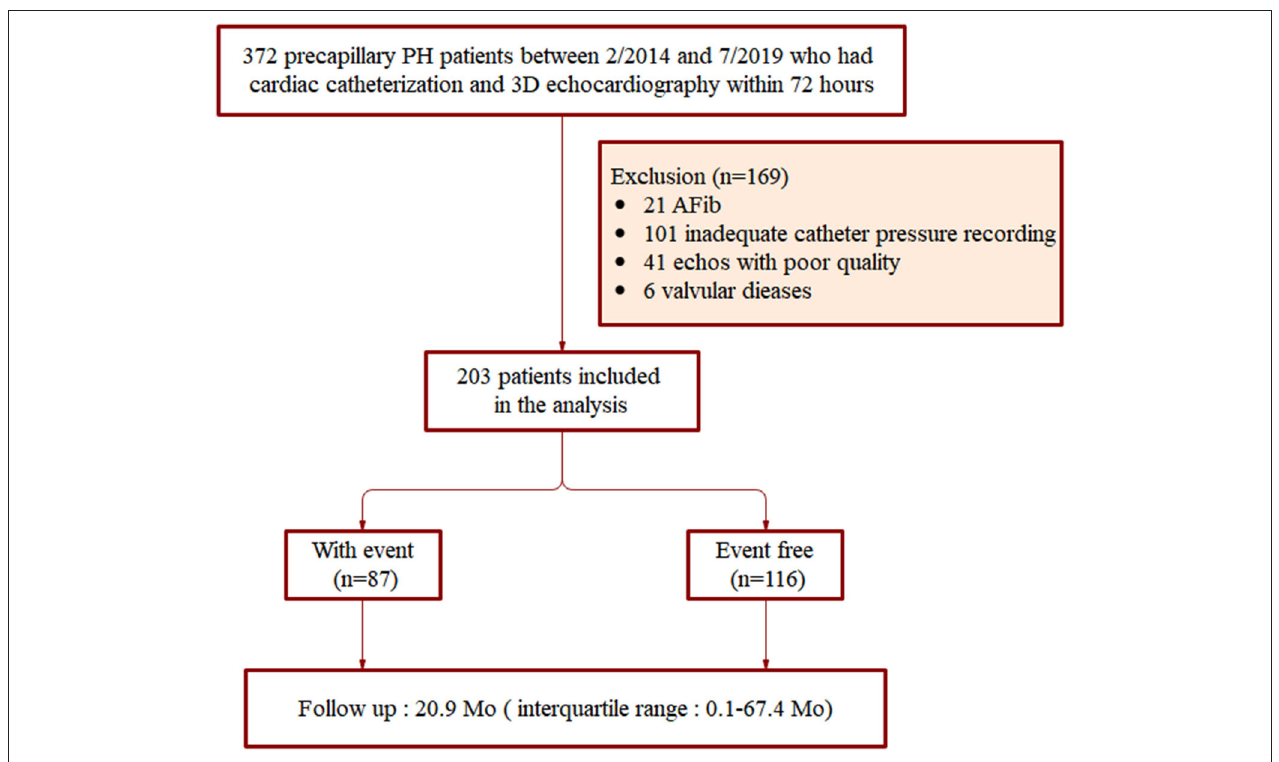
FIGURE 1 | Flow chart of patient